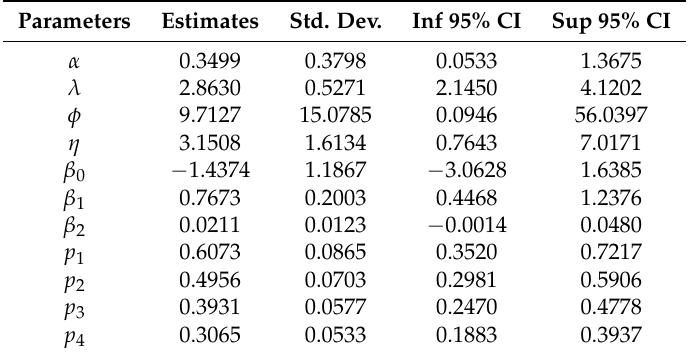
Table 6. MLEs of the Negative Binomial Kumaraswamy Exponential model for the melanoma data set. Parameters